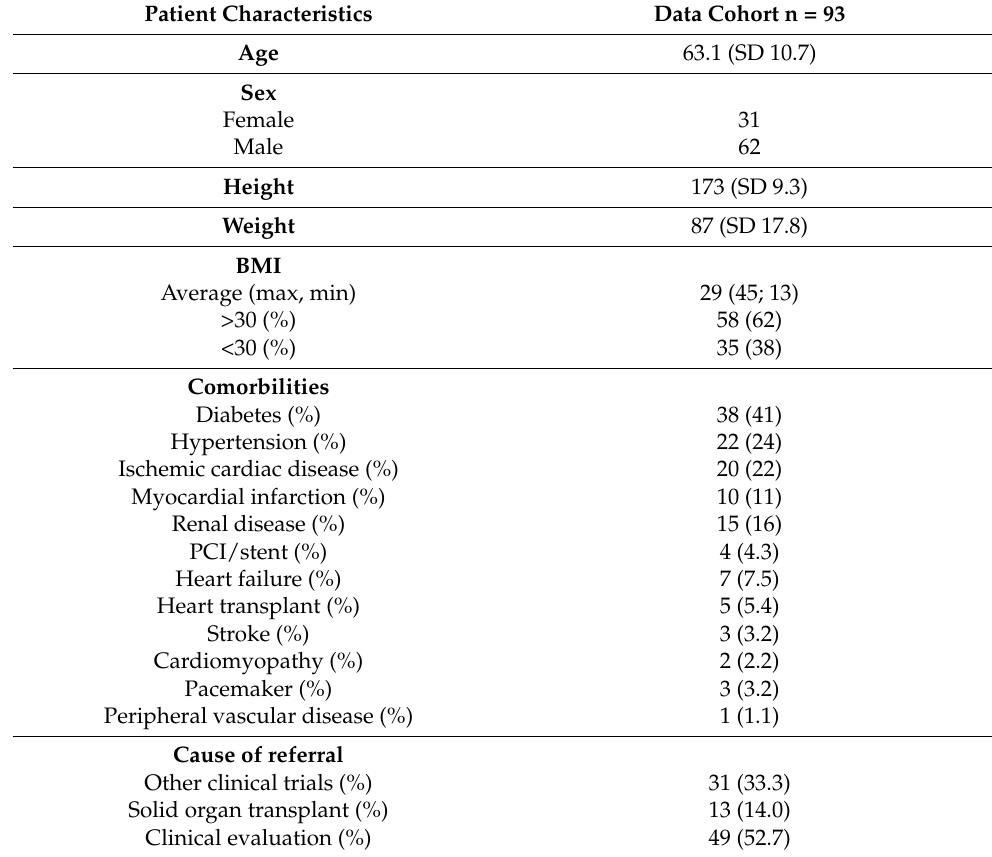
Table 1. Demographic data on patients having PET-CT with adenosine stress test. Age is given in years, weight in kilograms, height in centimeters, BMI = body mass index and is given in kg/m 2 . Ischemic Heart disease: chronic myocardial ischemia (17), stable angina (6), unstable angina